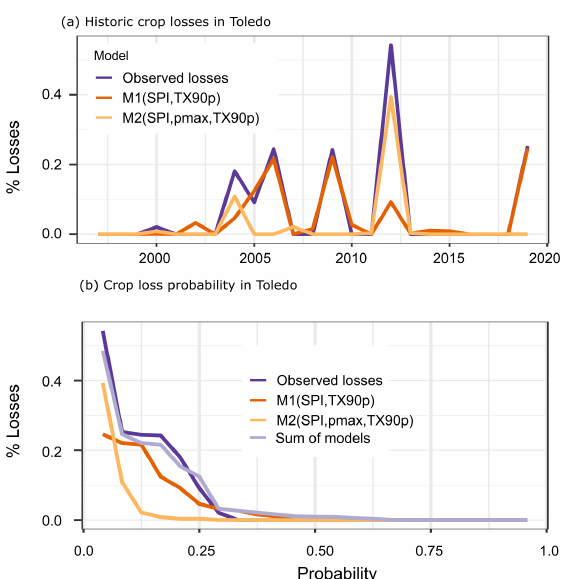
Figure 5. Risk analysis module applied to the city of Toledo, Paraná, Brazil (1197.016km 2 ), demonstrating the multi-hazard model M1(SPI,TX90p), multi-hazard model M2(SPI,pmax,TX90p), sum of the two models, and observed crop losses in the studied period. (a) Simulation of crop losses and (b) crop loss probability in the studied period, including the sum of the losses estimated with two loss